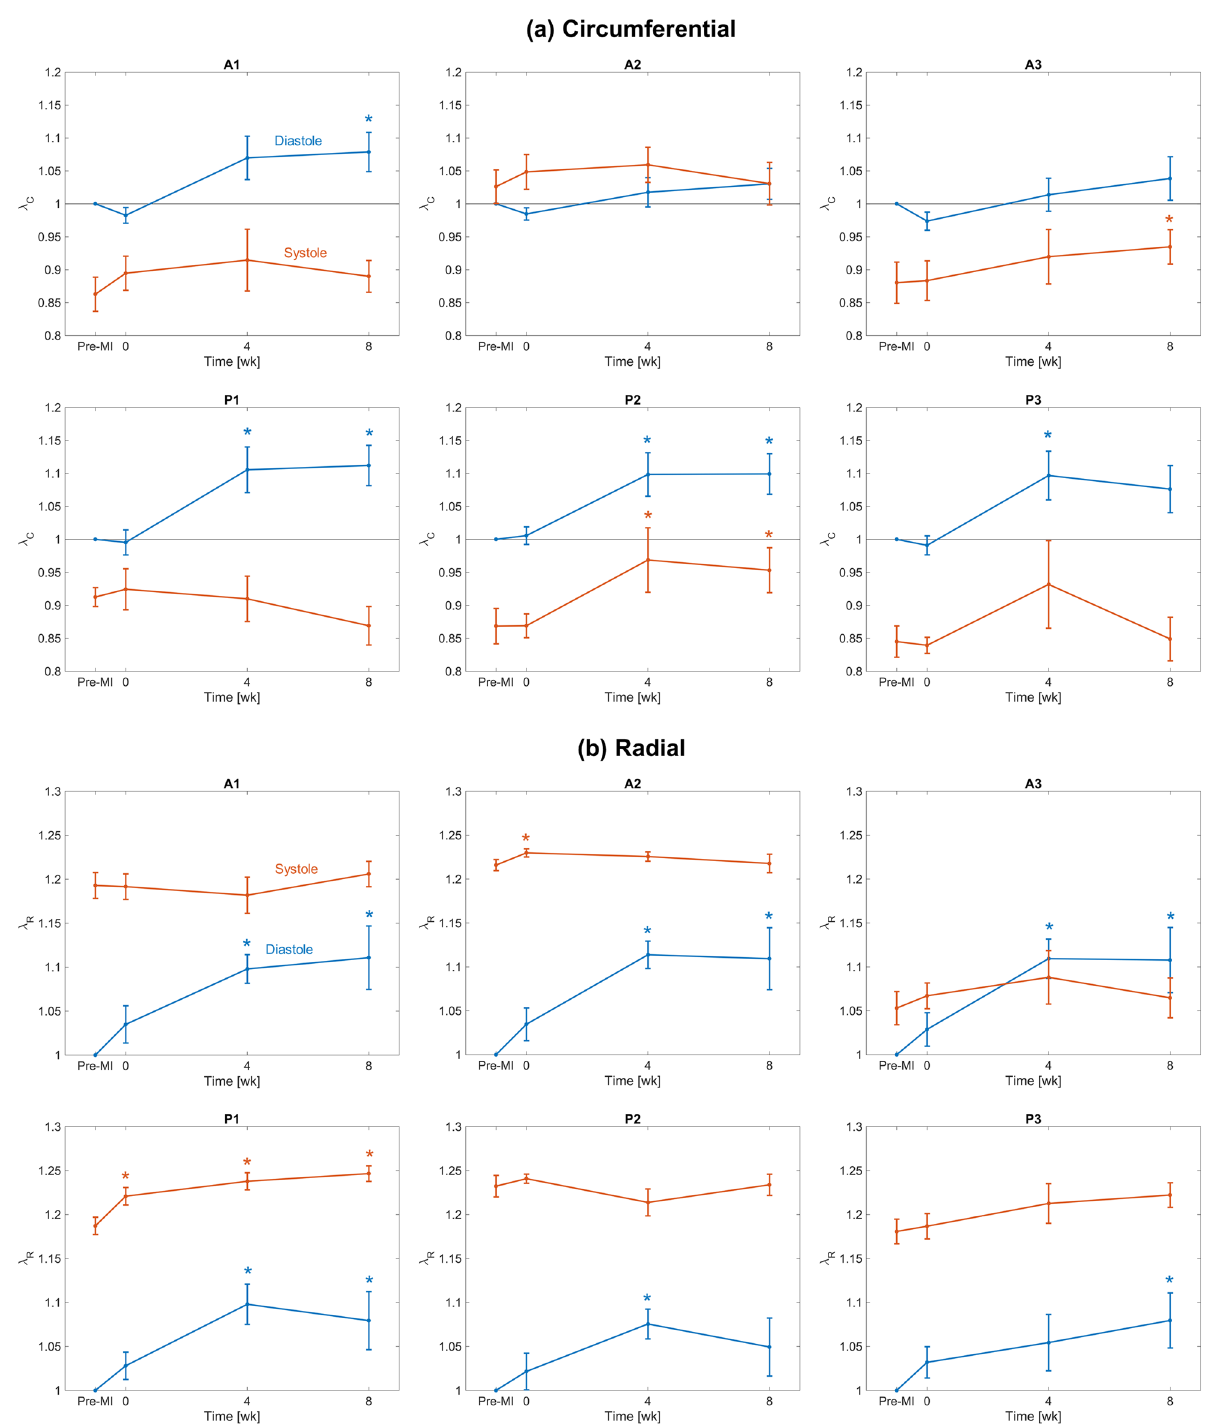
Figure 6. ( a ) Circumferential and ( b ) radial stretches in both diastole and systole for each Carpentier leaflet segment, referenced to the pre-MI diastolic configuration. Lines and error bars at each time point denote the mean and standard error across n = 8 specimens. Asterisk symbols (*) denote statistically significant differences from the corresponding pre-MI value with 95% confidence ( p < 0.05 yielded by a paired t